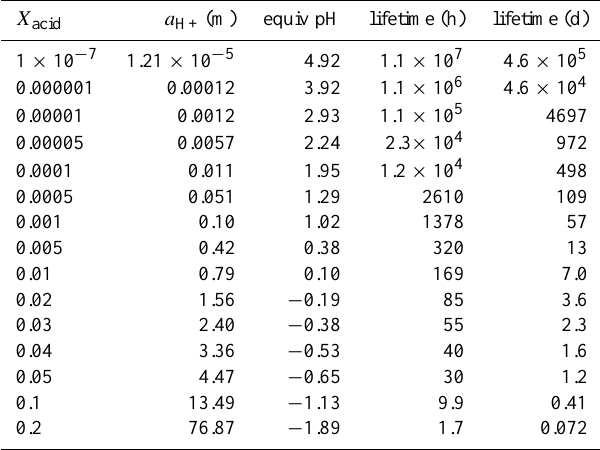
Table 9. Predicted 2-MG diester production lifetimes as a function of acid content and fixed 2-MG content ( X 2-MG = 0 .